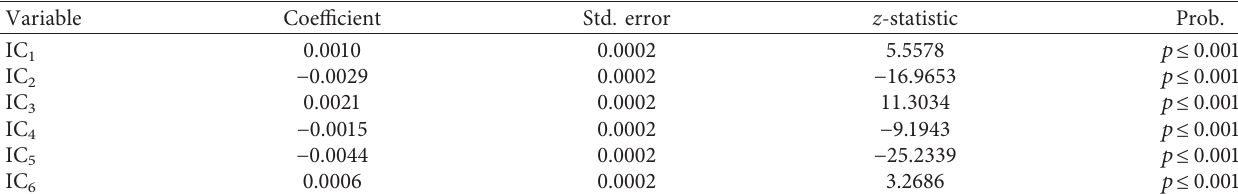
Table 4: The results estimated by the ICA-based ARMA-APARCH-M model for cluster 2. Variable